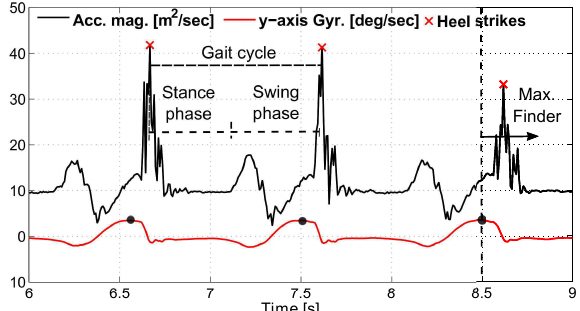
Figure 2: The procedure to detect the heel strike us- ing accelerometers and gyroscopes: First we detect the ending of the swing phase represented as a peak in the gyroscope information. Then we look in the next period of acceleration data to detect the peak in acceleration corresponding to the heel